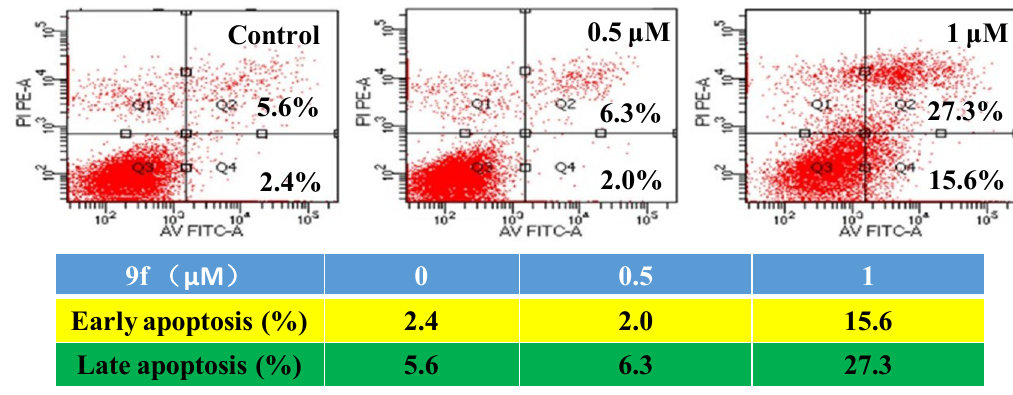
Figure 7. Compound 9f could induce apoptosis of MCF-7 cells.